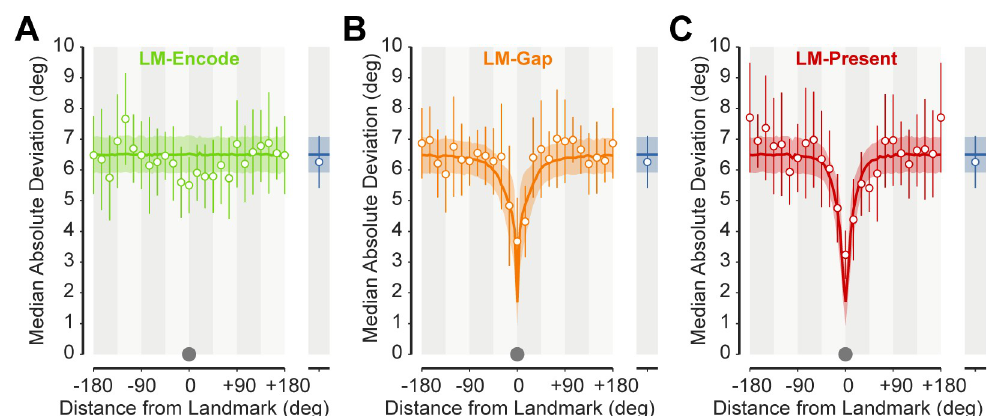
Fig 3. Experiment two. (A-C) Mean variability in memory recall across participants for LM-ENCODE (A), LM-GAP (B) and LM-PRESENT (C) conditions (with LM-ABSENT shown on the right in blue). There is a substantial reduction in variability in the vicinity of the landmark irrespective of whether the landmark was persistently (LM-PRESENT) or intermittently shown (LM-GAP), but no apparent influence of the visual landmark when it was only visible during encoding (LM-ENCODE). Predictions of the best-fitting model are